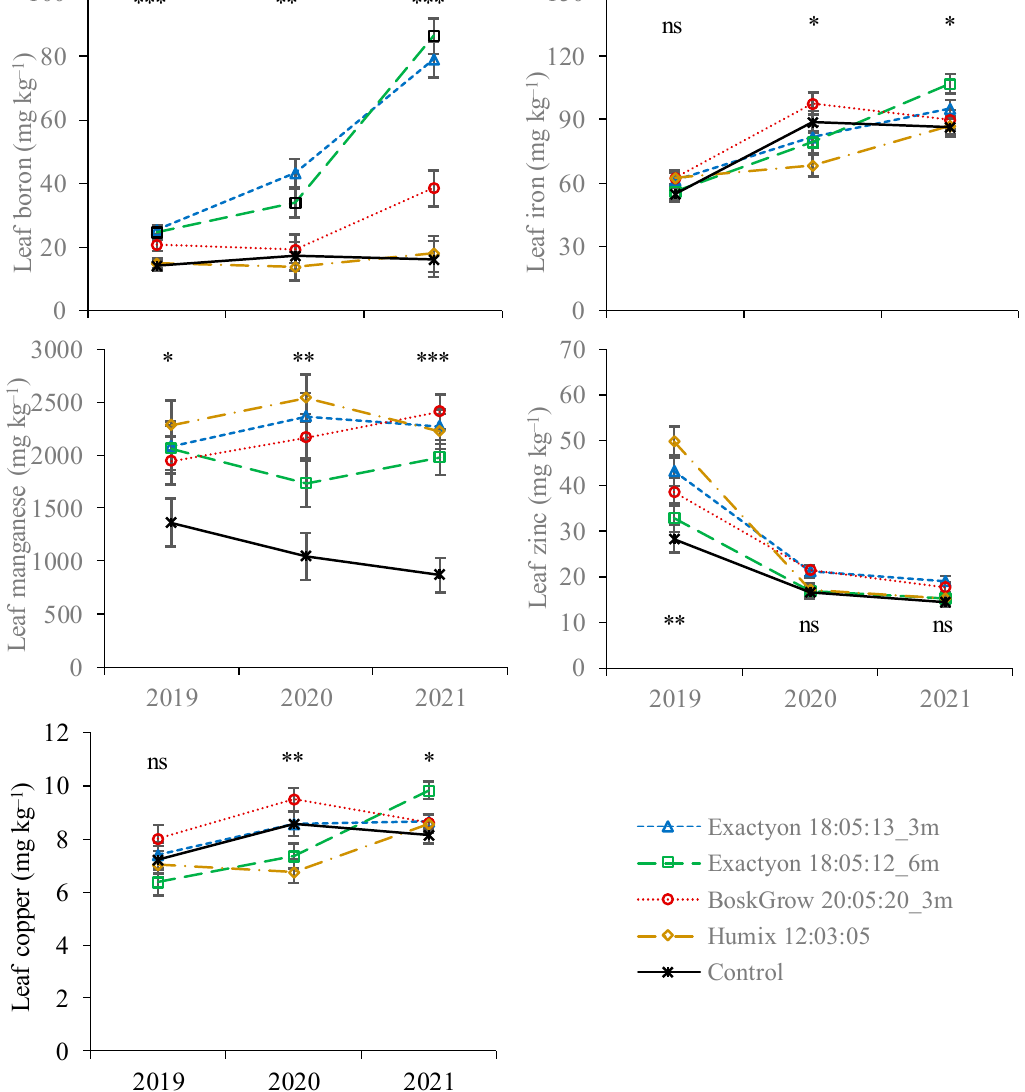
Figure 3. Average concentration and standard error of the mean of boron, iron, manganese, zinc and copper concentrations in chestnut leaves collected in July of 2019, 2020 and 2021 as a function of fertilization treatments. * p ≤ 0.05; ** p ≤ 0.01; *** p ≤ 0.001; ns, not significant.